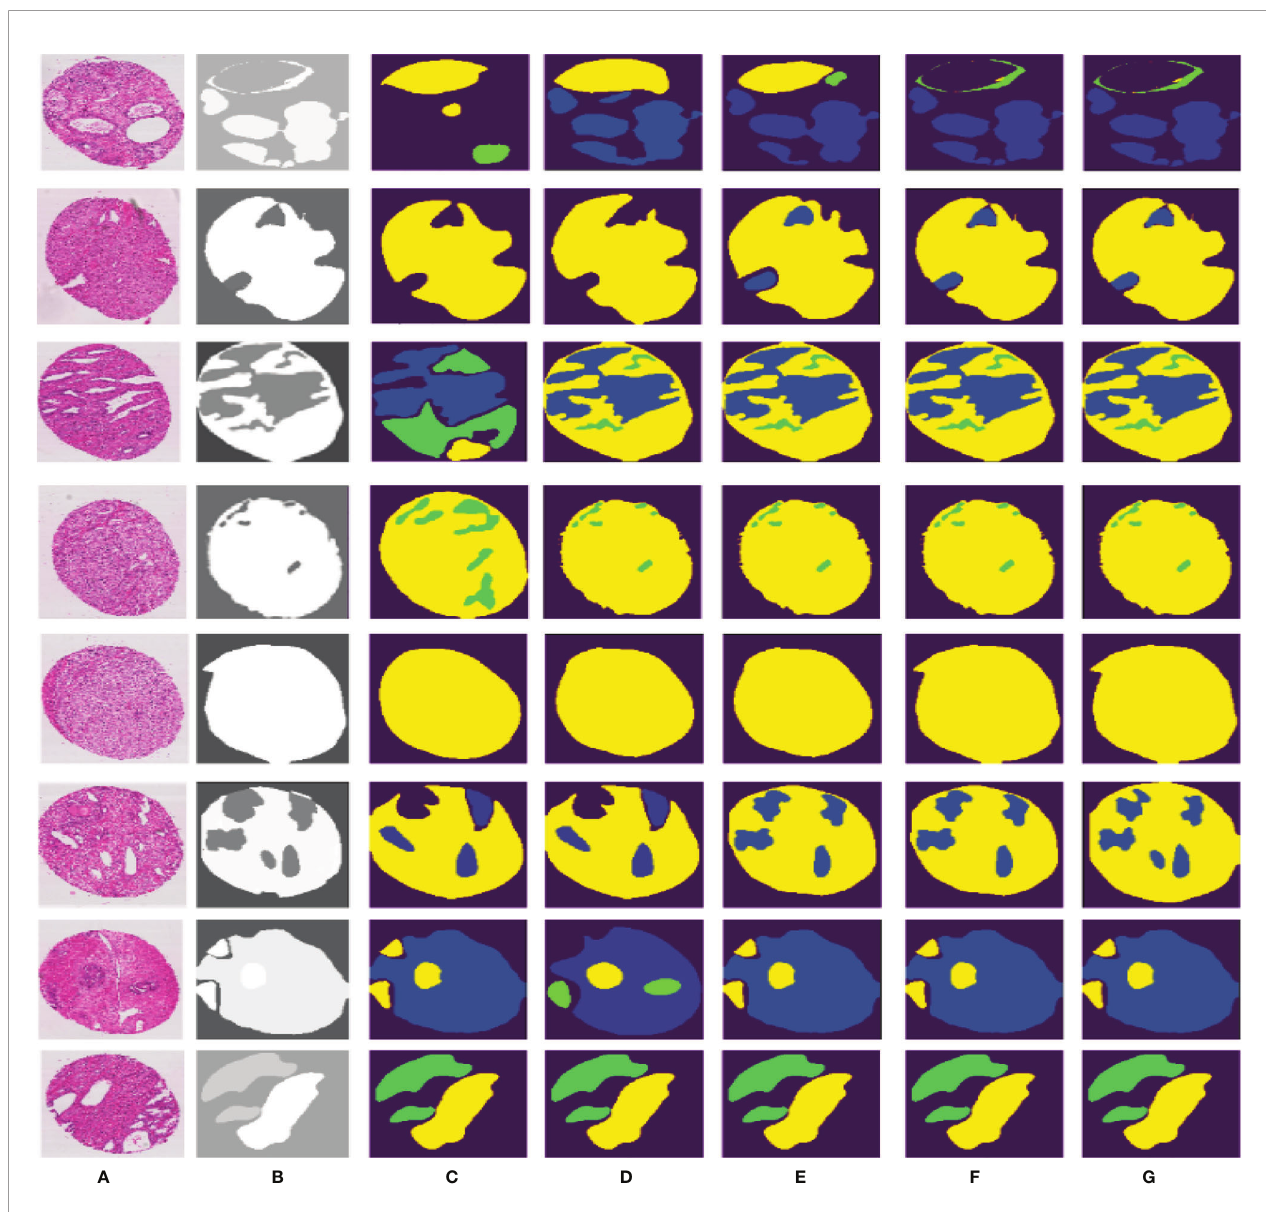
FIGURE 7 | Different segmentation results from FCN, SegNet, U-Net, DeepLabv3, and our proposed method. Column (A) is the input image, column (B) is the fi nal expert annotation used by the sample algorithm, and columns (C – G) indicate the fi nal segmentation results of FCN, SegNet, U-Net, DeepLabv3, and PSPNet,